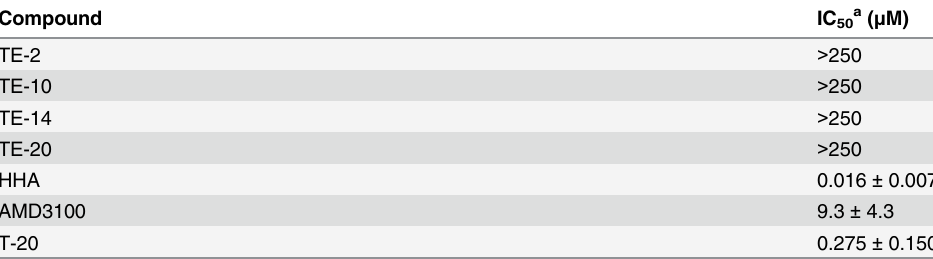
a 50% Inhibitory concentration or compound concentration required to inhibit syncytium formation between persistently HIV-1-infected HuT-78 cells and uninfected SupT1 cells by 50% after ~ 24 hours of cell co- cultivation. Data are derived from 2 independent